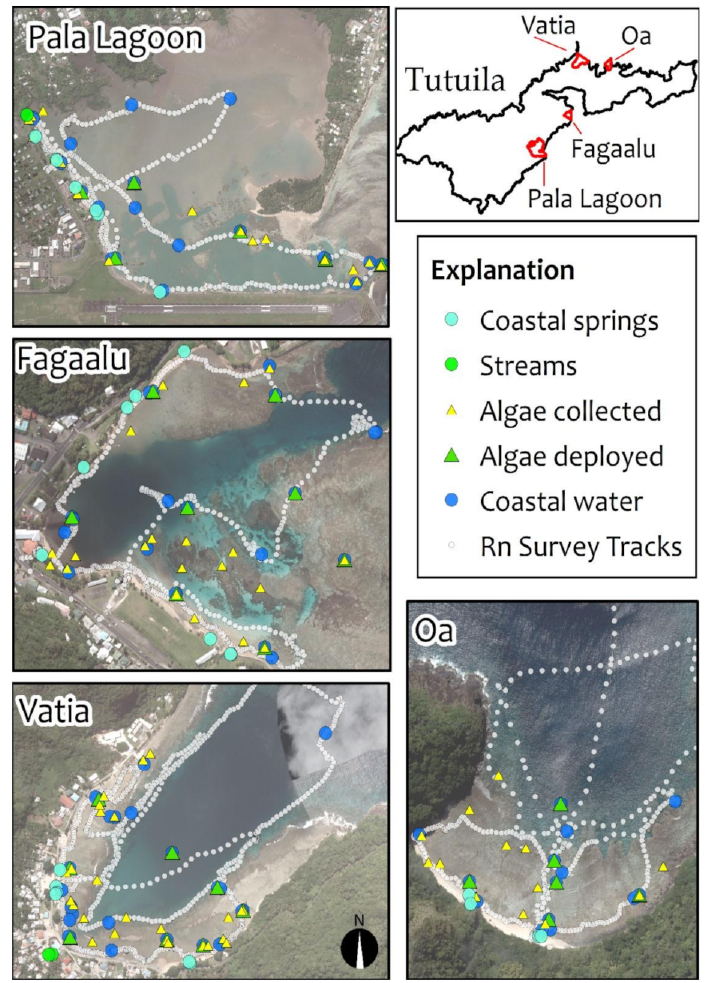
Figure 2. Study location maps showing sampling sites for coastal water (small blue circles), CGW (large cyan circles), streams at baseflow stage (larger green circles), in situ collected macroalgae (smaller yellow triangles), deployed macroalgae (larger green triangles), and tracks of 222 Rn surveys (grey